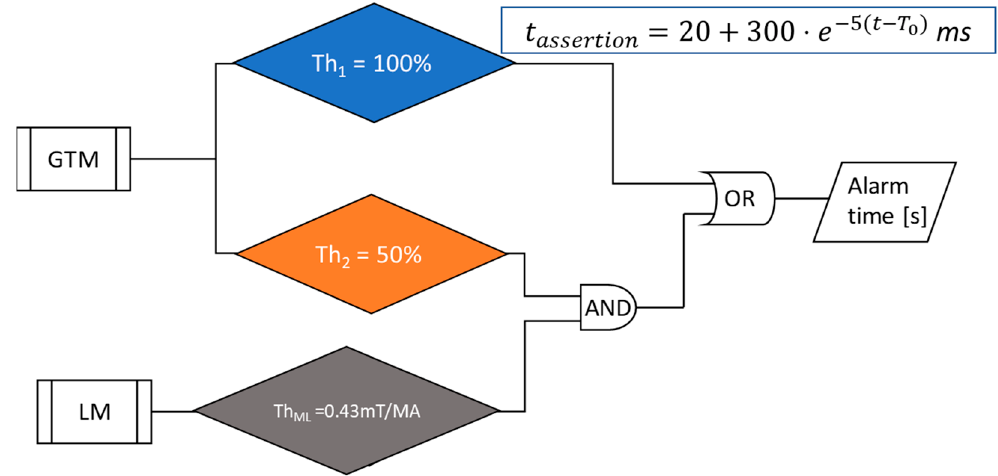
Figure 6. Multiple conditions alarm scheme of the GTM disruption predictor ( T 0 is the starting time of the flattop).